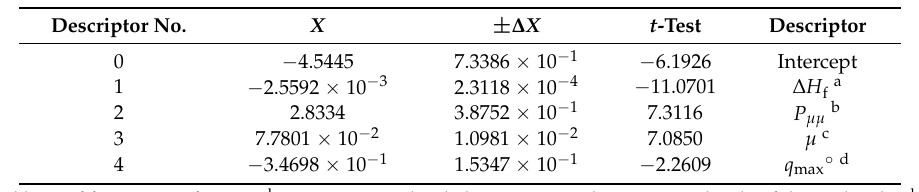
Figure 1. The “breaking point” rule results. The black code indicates a statistically notable improvement in the correlation coefficient, and the red code indicates it was not improving obviously. Table 2. The best four-descriptor